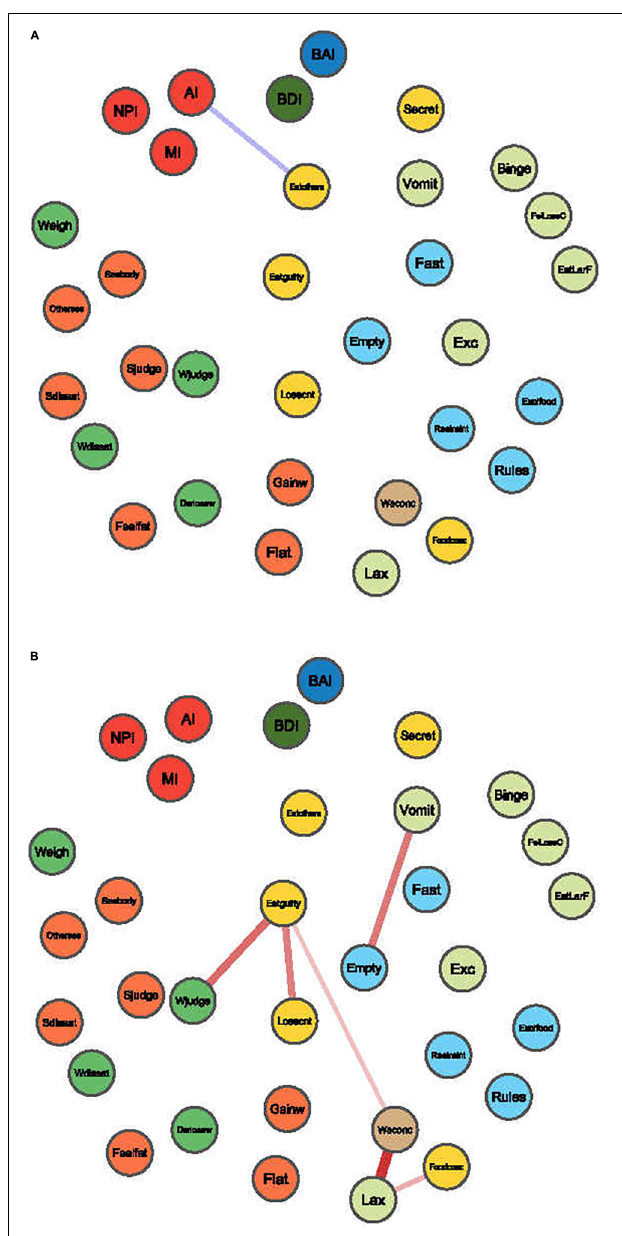
FIGURE 6 | Edges exhibiting significant differences between BN and HC. The blue edges denote the increased correlations between items in the BN compared with those in the HC network (A) , and red edges denote the decreased correlations (B) .